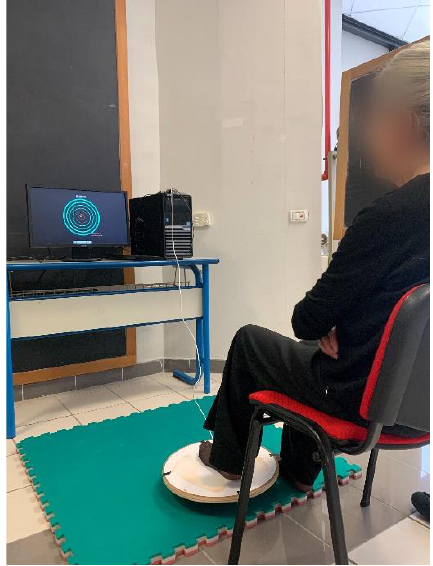
Figure 1. Standard lower limb Wobble Board test position.